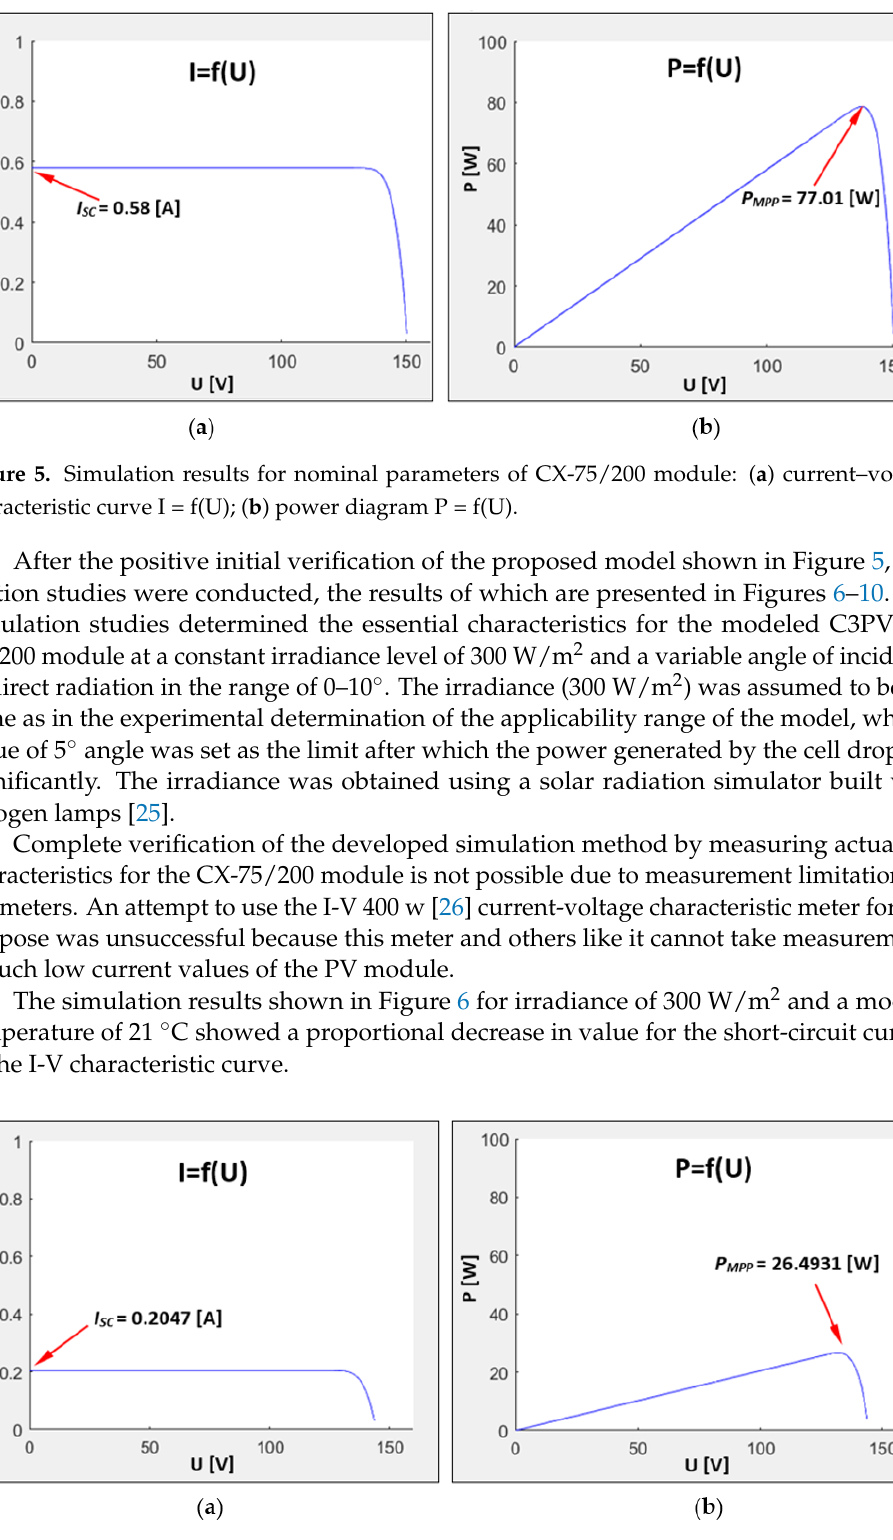
Figure 7. Simulation results for irradiance of 300 W/m 2 deflected by an angle Δ θ = 2° from the di- rection of perpendicular incidence and a temperature of 21 °C for the modeled CX-75/200 module: ( a ) current–voltage characteristics I = f(U); ( b ) power graph P = f(U).